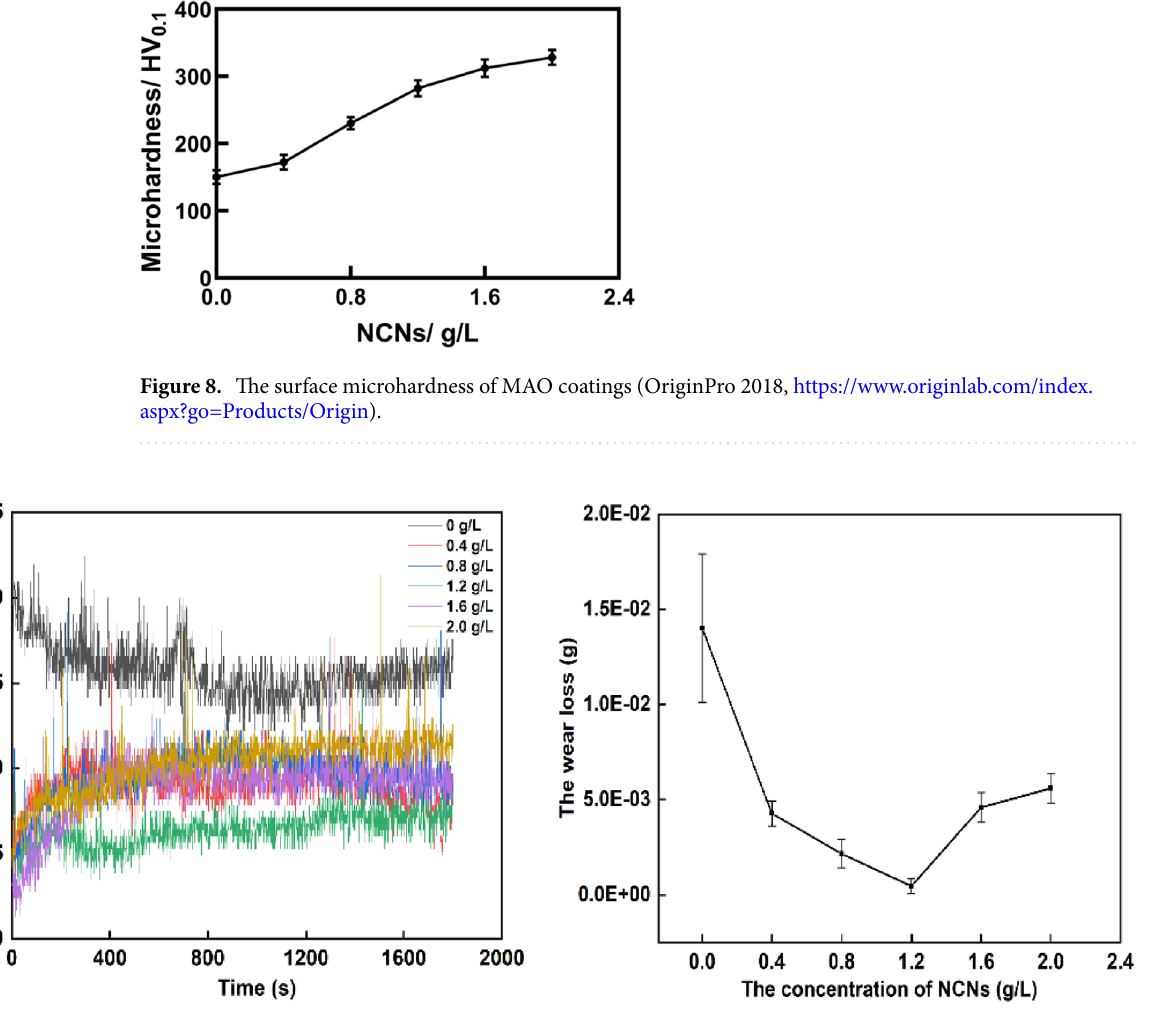
Figure 9. The friction coefficients and wear loss of MAO coatings (OriginPro 2018, https:// www. origi nlab. com/ index. aspx? go= Produ cts/ Origin; Adobe Illustrator CS5, https:// www. adobe. com/ cn/ produ cts/ illus trator. html#